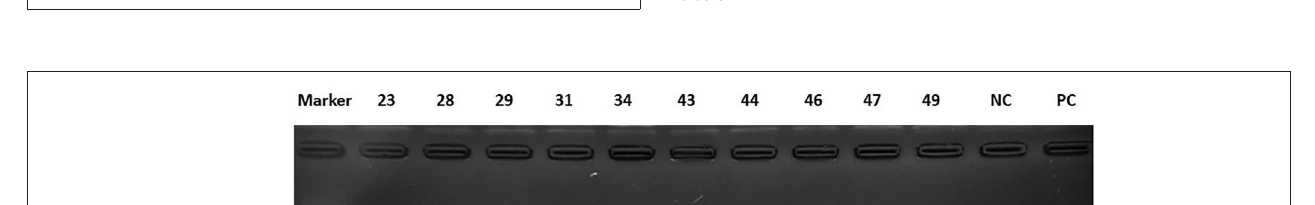
FIGURE 1 | (A) Box and whisker plots for the age of the patients according to gender. (B) The frequency of breeds of patients suffering from superficial pyoderma included in the study.